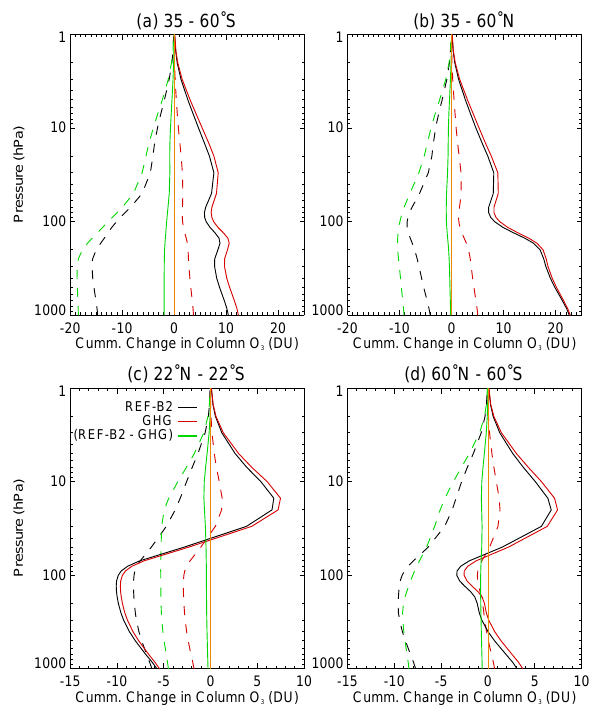
Fig. 10. The vertical integral, from 0.1 hpa downwards, of the change in ozone for the REF-B2 (black) and GHG (red) experiments, along with the effects of ODSs derived as the (REF-B2–GHG) difference (green). The changes are relative to the 1960–1974 average and are shown for 1990–2009 (dashed lines) and 2080–2099 (solid lines) for the latitude bands 35–60 ◦ S (a) , 22 ◦ N–22 ◦ S (b) , 35–60 ◦ N (c) and 60 ◦ N–60 ◦ S (d) .